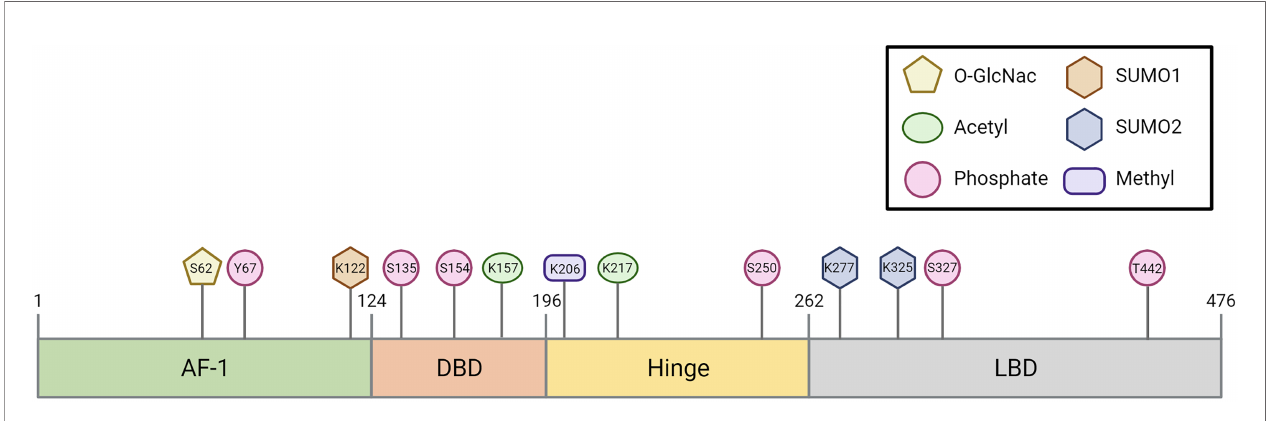
FIGURE 1 | Schematic representation of the post-translational modi fi cations within the